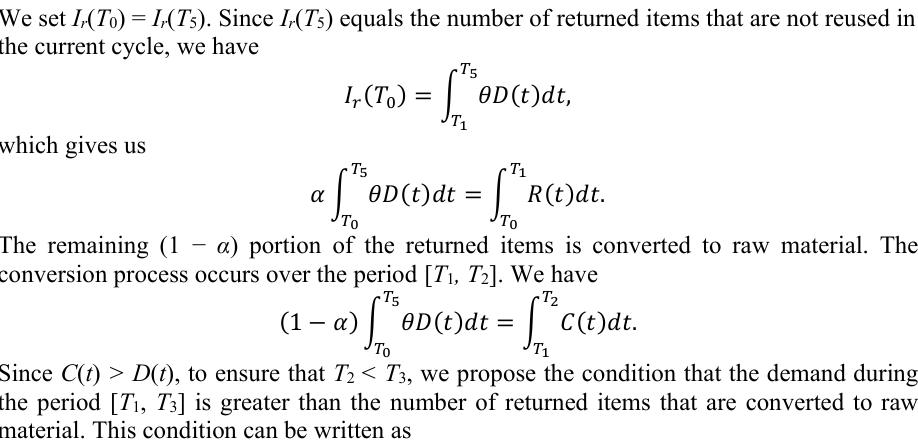
Fig. 2. Inventory movement the proposed inventory system for increasing